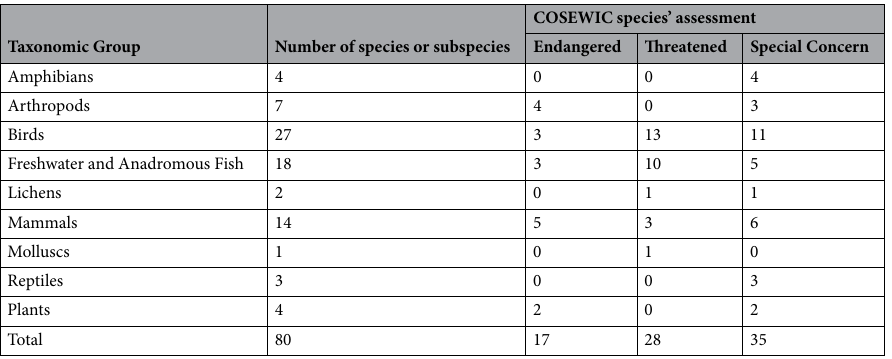
Table 3. Taxonomic representation of number of species/subspecies assessed as Endangered, Threatened or Special Concern by the COSEWIC across the boreal caribou distribution. Species were included only if human disturbance was identified as a threat to